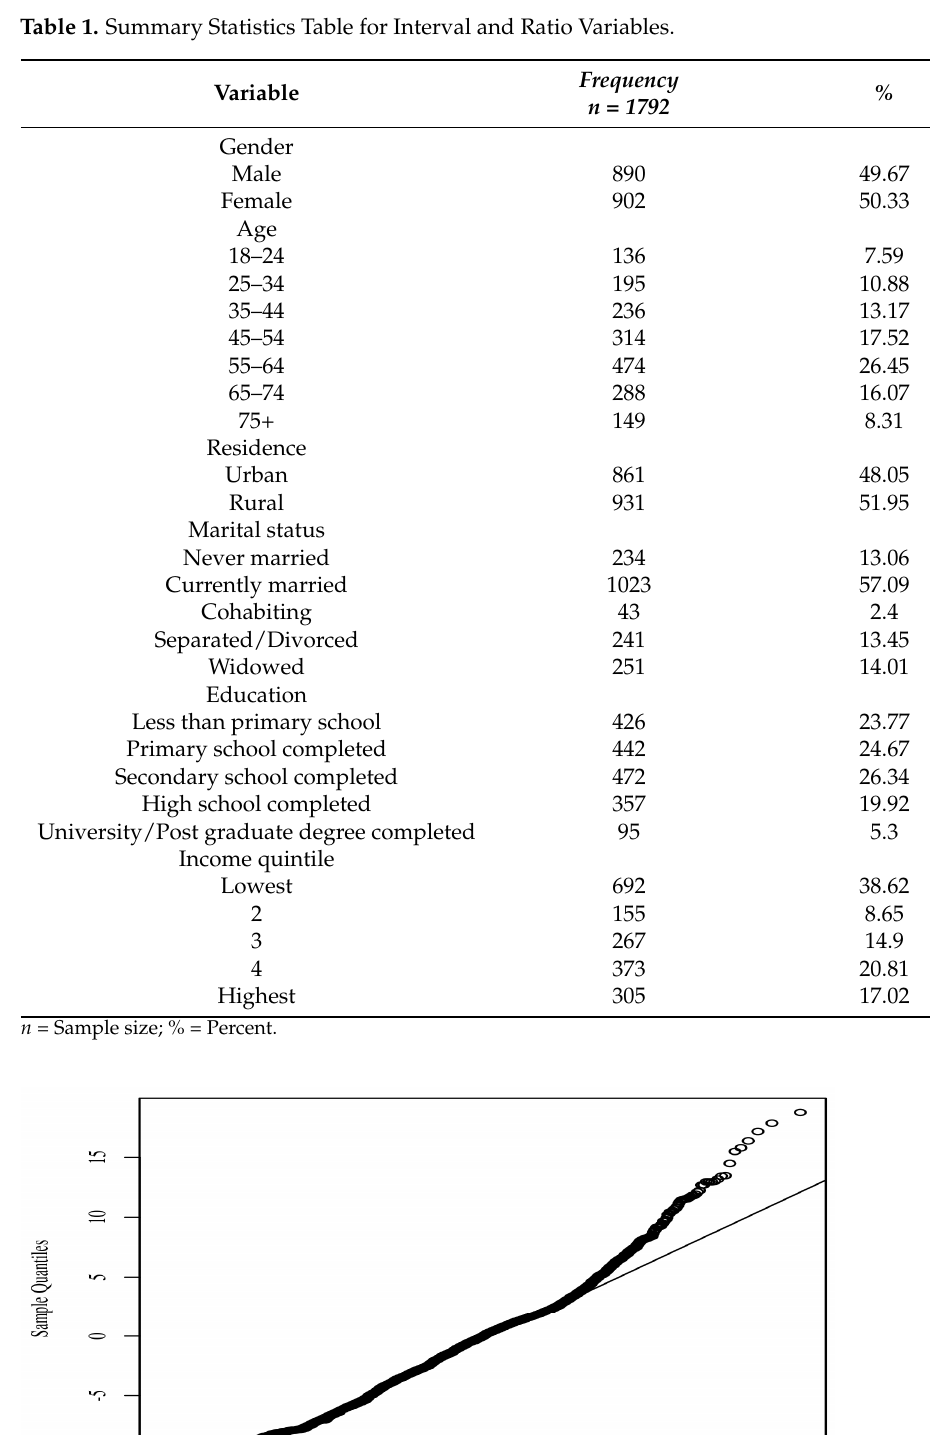
Table 1. Summary Statistics Table for Interval and Ratio Variables.